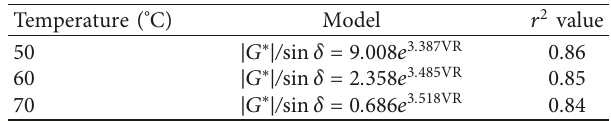
G / sin δ and VR for the stone | | ∗